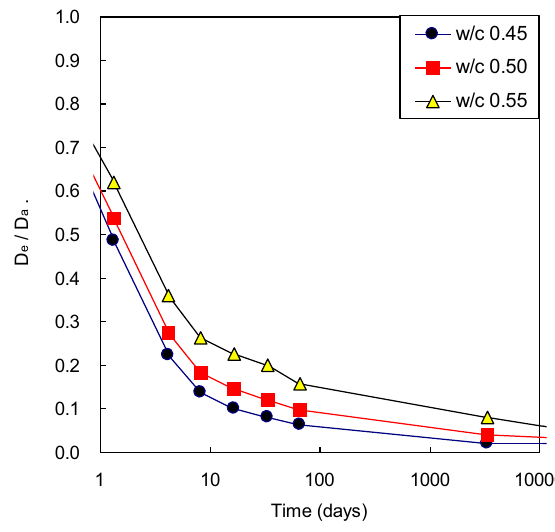
Fig. 11 Comparison of effective oxygen diffusivity of concrete (D e ) and apparent oxygen diffusivity (D a ) of carbon- ated